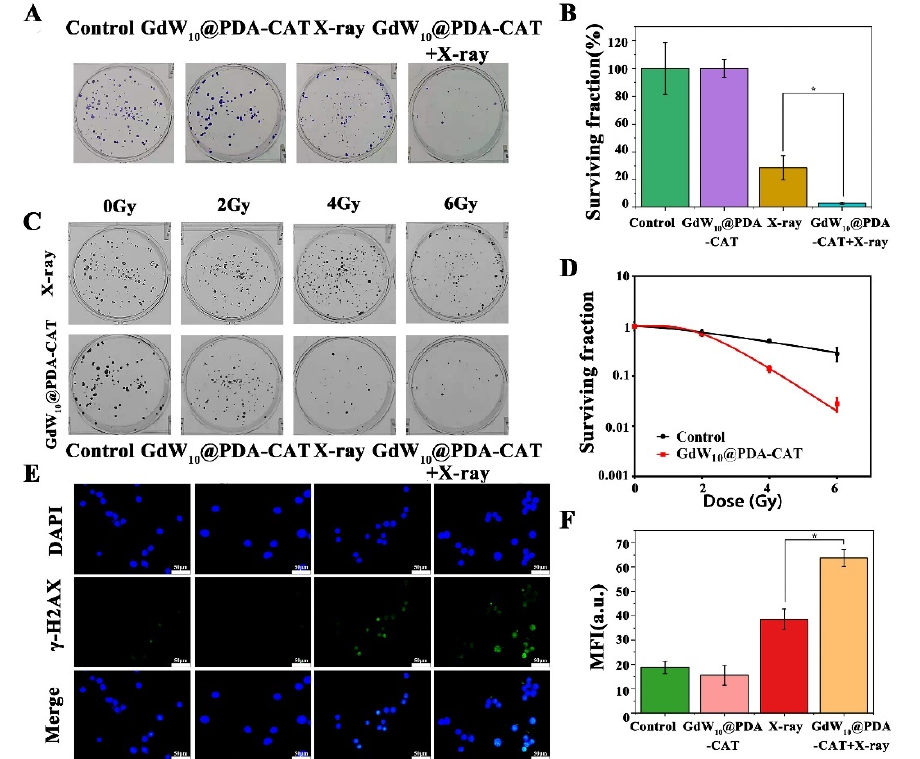
Figure 5. In vitro colony formation assay and DNA double-strand damage in HT29 cells. ( A ) Proliferation of HT29 cells under different treatments in vitro (GdW 10 @PDA-CAT: 50 μ g/mL, X-ray: 6 Gy). ( B ) Survival fraction of HT29 cells after different treatments. ( C ) Colony formation analysis of HT29 cells treated with or without GdW 10 @PDA-CAT at different radiation doses. ( D ) Corresponding cell survival fraction after different treatments. ( E ) Representative immunofluorescence images of γ -H 2 AX with different treatments inducing DNA double strand breaks. The scale bar is 50 μ m. ( F ) Quantitative analysis of FITC in cells with different treatments. The p Values were cal- culated by the Student’s t test: * p < 0.01.